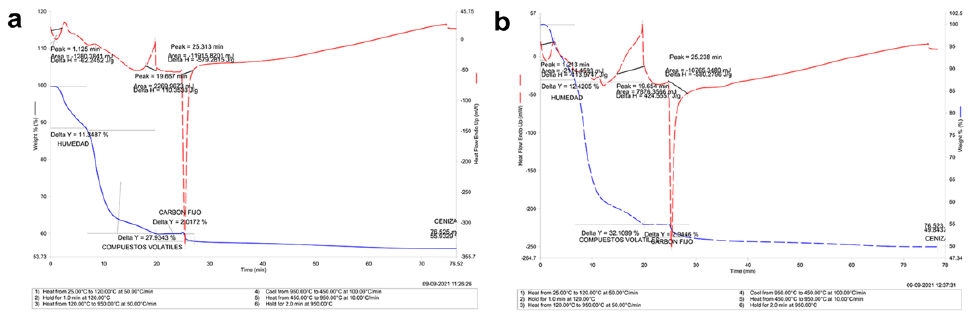
Figure 9. Thermogravimetric Analysis-TGA (Compositional) in mandibular bone. ( a ) Farmed fish.